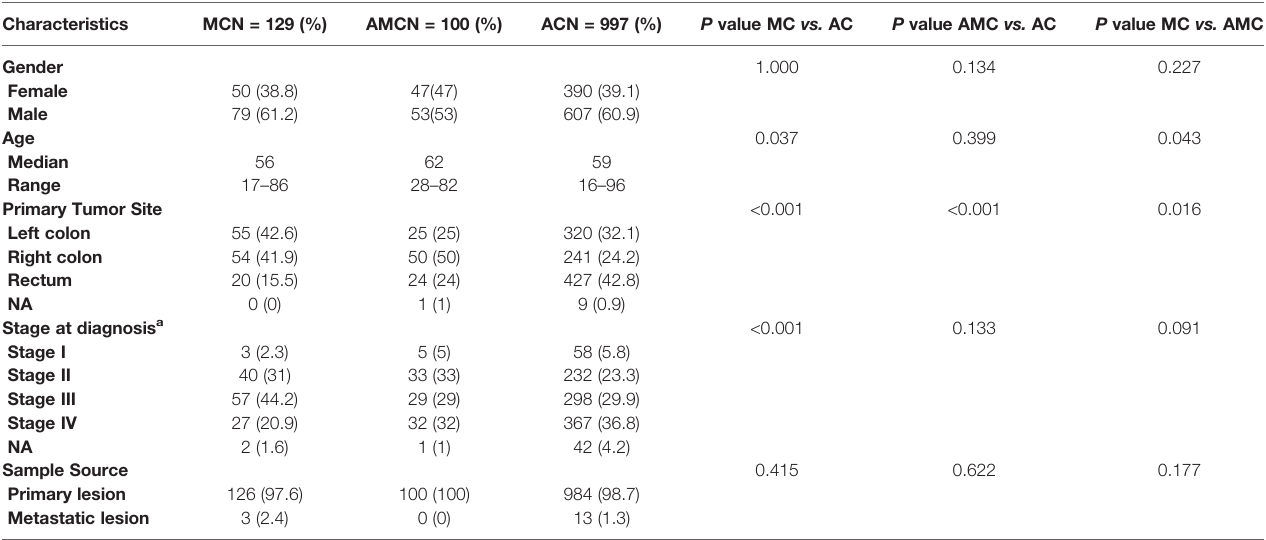
TABLE 1 | Patient and tumor